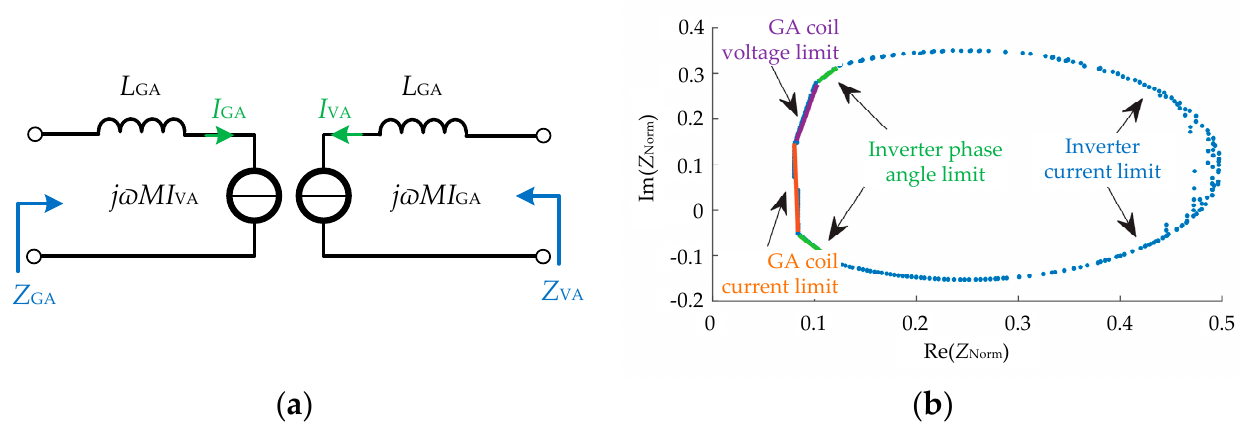
Figure 11. Interoperability evaluation method based on port impedance ( a ) Schematic of port impedance; ( b ) Z GA standard mapping region.